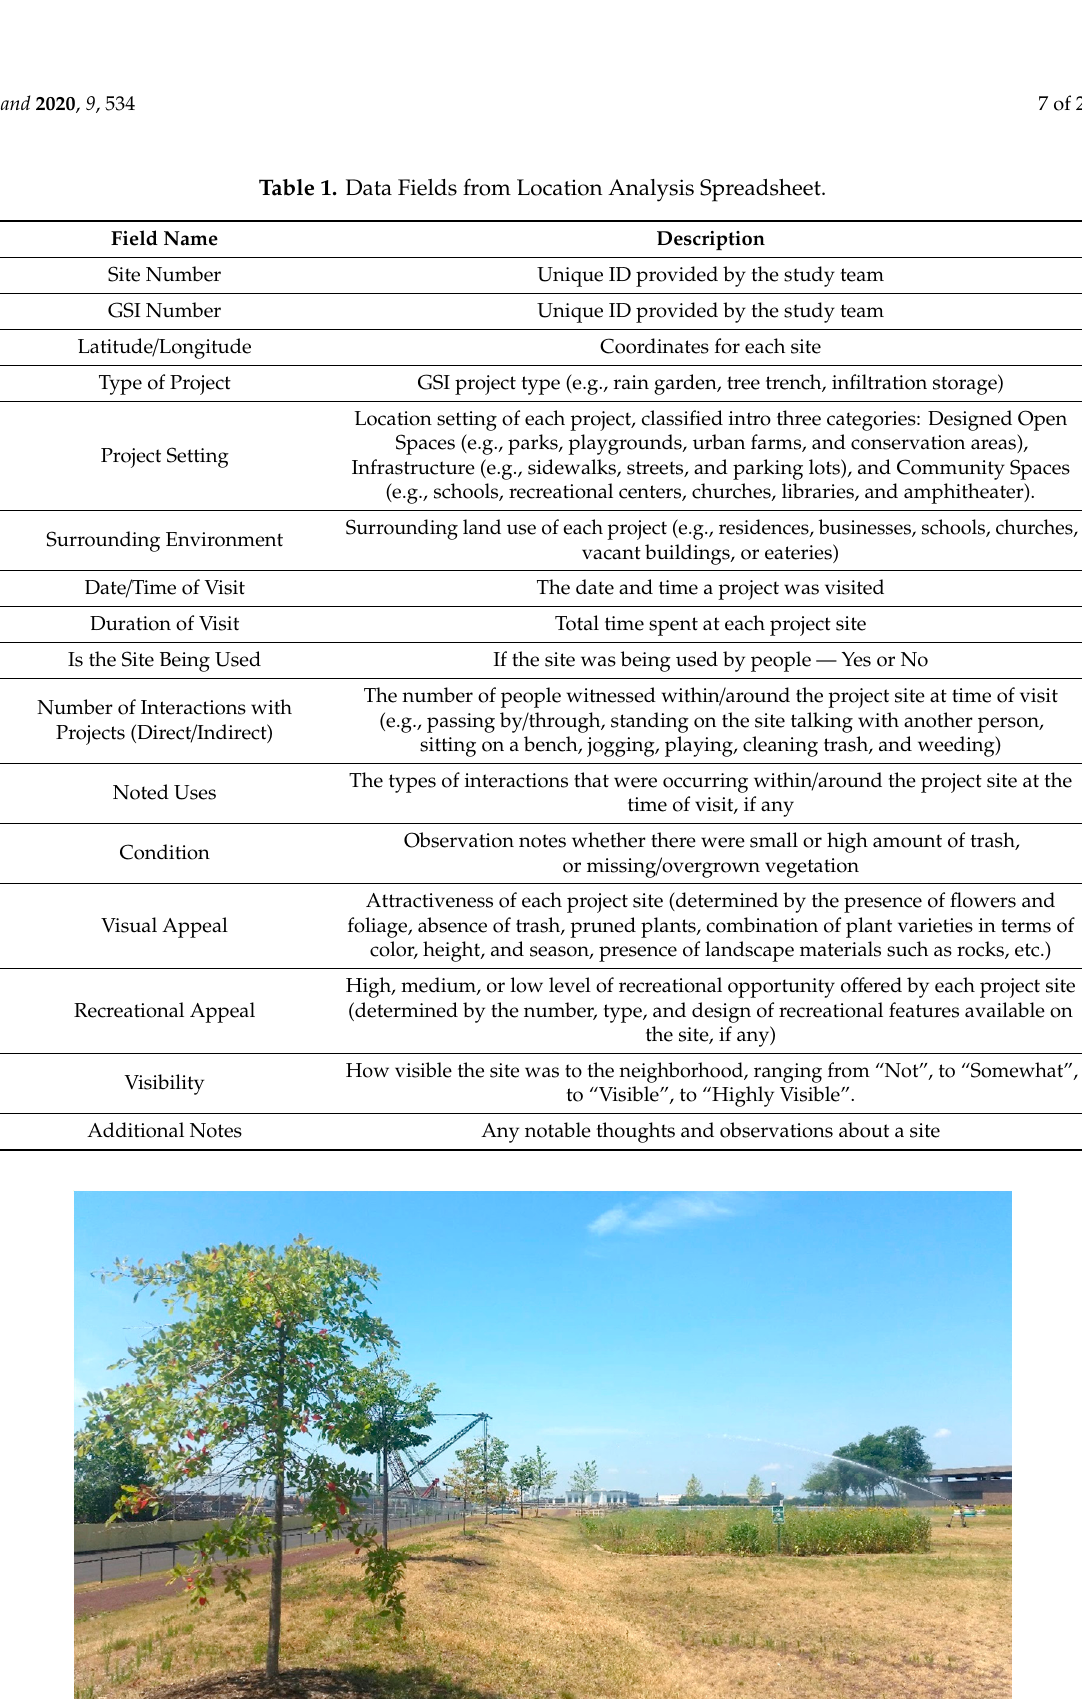
Figure 3. Four examples of highly visible and well-maintained GSI projects in Philadelphia. ( a ) a porous paving project designed as passive recreational area with seating arrangement and designed landscape; ( b ) a series of tree trench projects with a visible signage and wide sidewalk; ( c ) a bioswale designed as part of a play space with a visible trash can; ( d ) a rain garden next to a busy road with vibrant plants and flower beds. Photos by Shane Walsh.